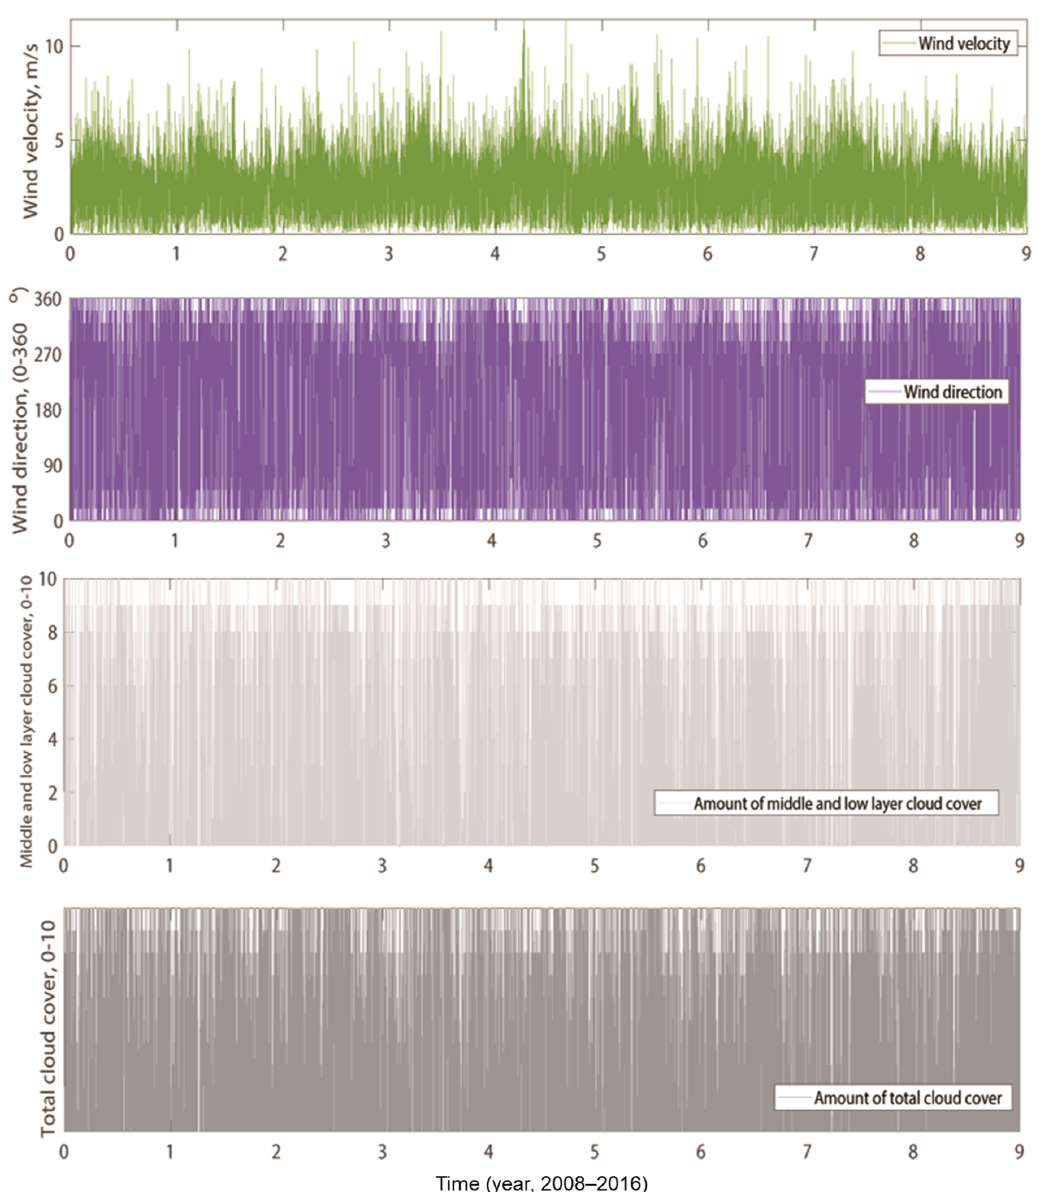
Figure 4. Historical data for 9 years (2008–2016): wind velocity, wind direction, amount of middle, low-layer cloud cover (MLcc) and amount of total cloud cover (Tcc).